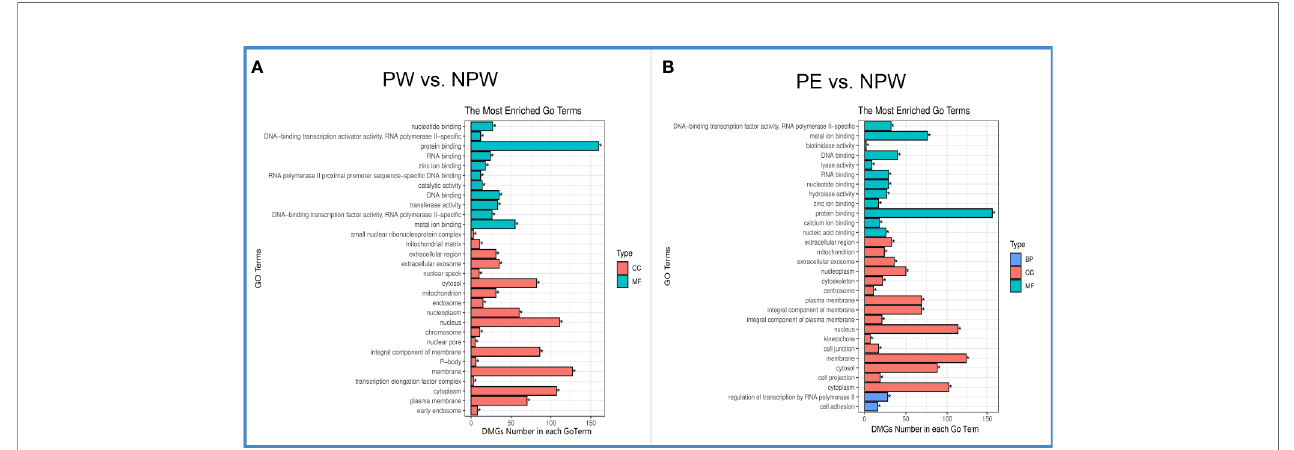
FIGURE 4 | Gene ontology (GO) of DMGs in the PW and PE groups. (A) The top 30 signi fi cantly different GO terms in the PW group were mainly in the cell component (CC) and molecular function (MF) categories. Green represents MF, and red represents CC. (B) The top 30 signi fi cantly differentially expressed GO terms in the PE group were in the CC, MF and biological process (BP) categories. Red represents CC, blue BP and green MF. *q <